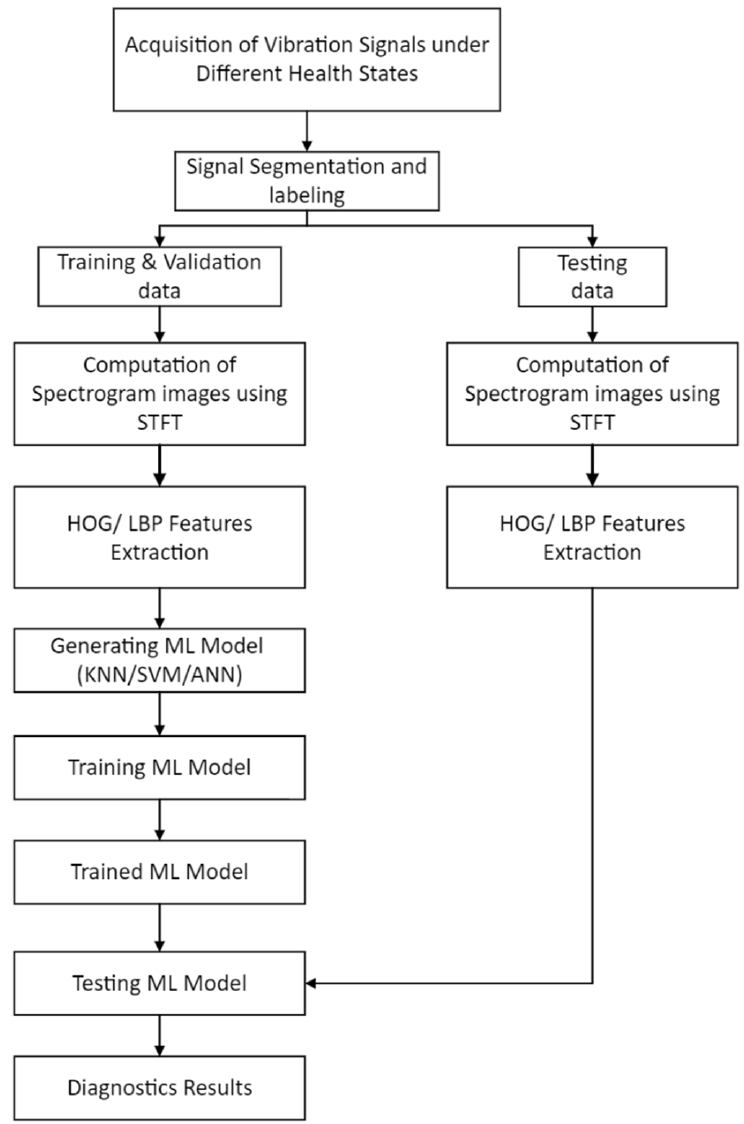
Figure 7. Method-III. Figure 7.